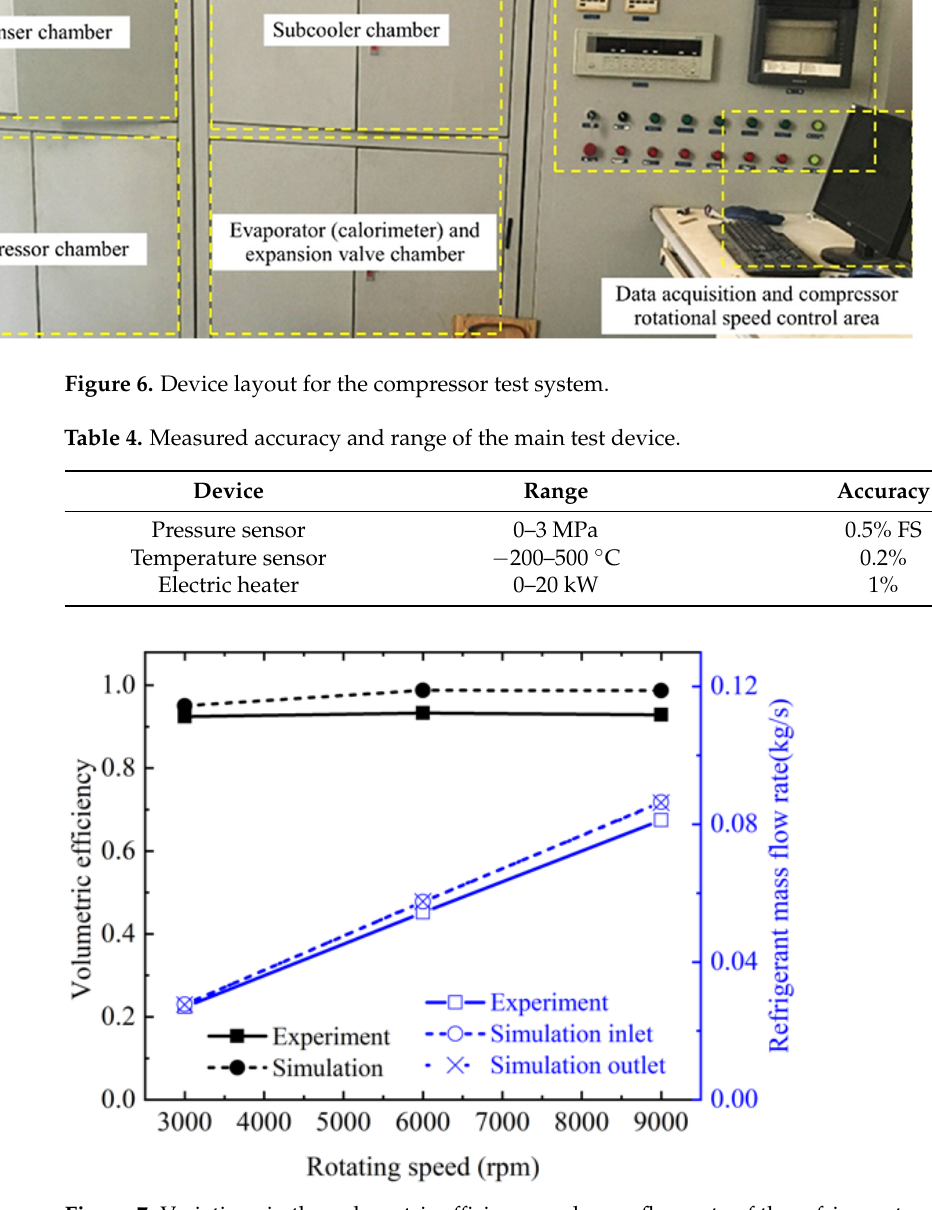
Figure 7. Variations in the volumetric e ffi ciency and mass fl ow rate of the refrigerant.